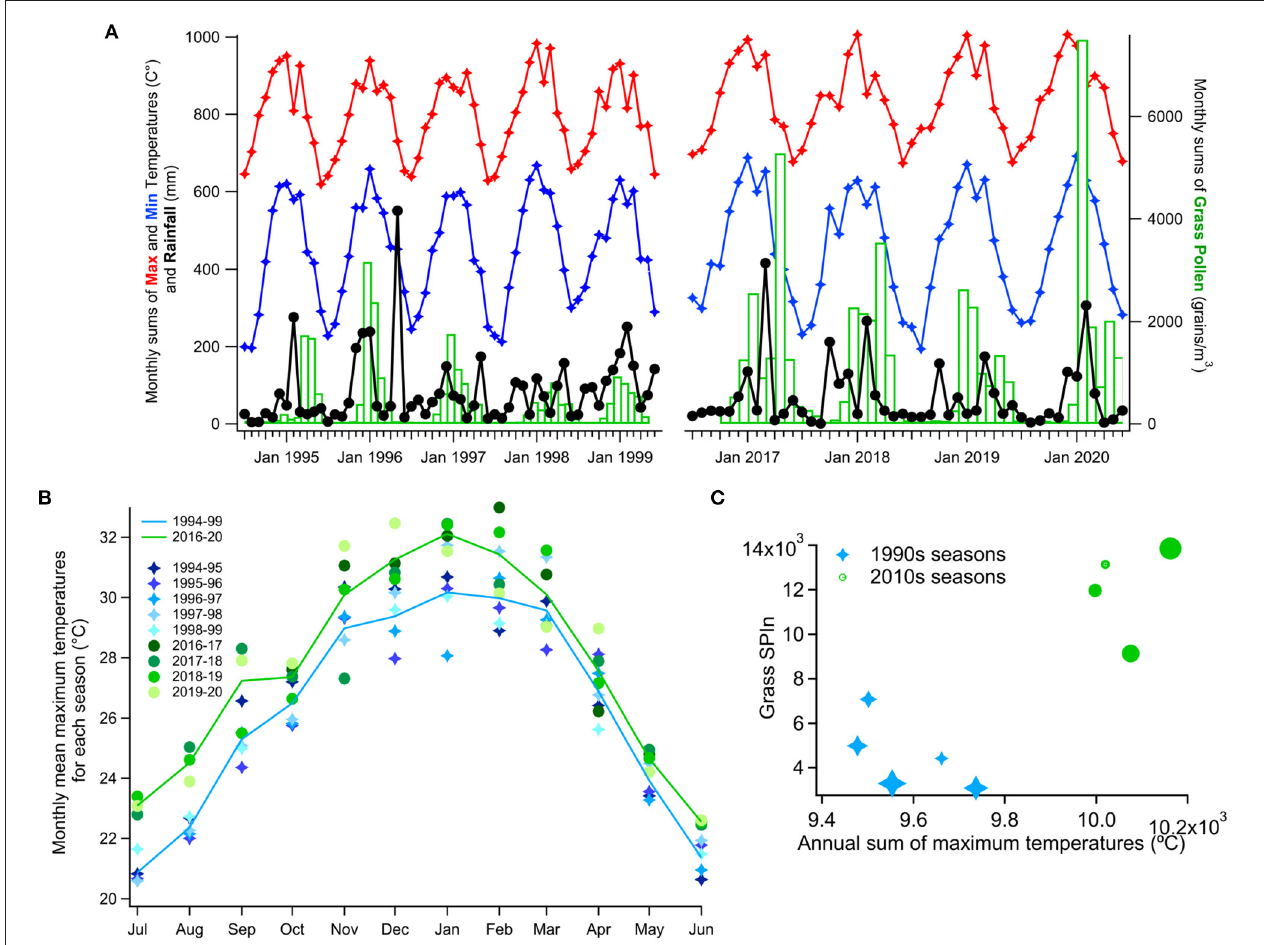
FIGURE 3 | Monthly and annual pollen, rainfall, and temperature. (A) Monthly sums of maximum and minimum temperature, rainfall, and grass pollen. (B) Monthly mean maximum temperature change between the two monitoring periods. (C) Annual pollen and maximum temperature sums (marker’s size increases with each season; from 1994-1995 to 1998-1999 and from 2016-2017 to